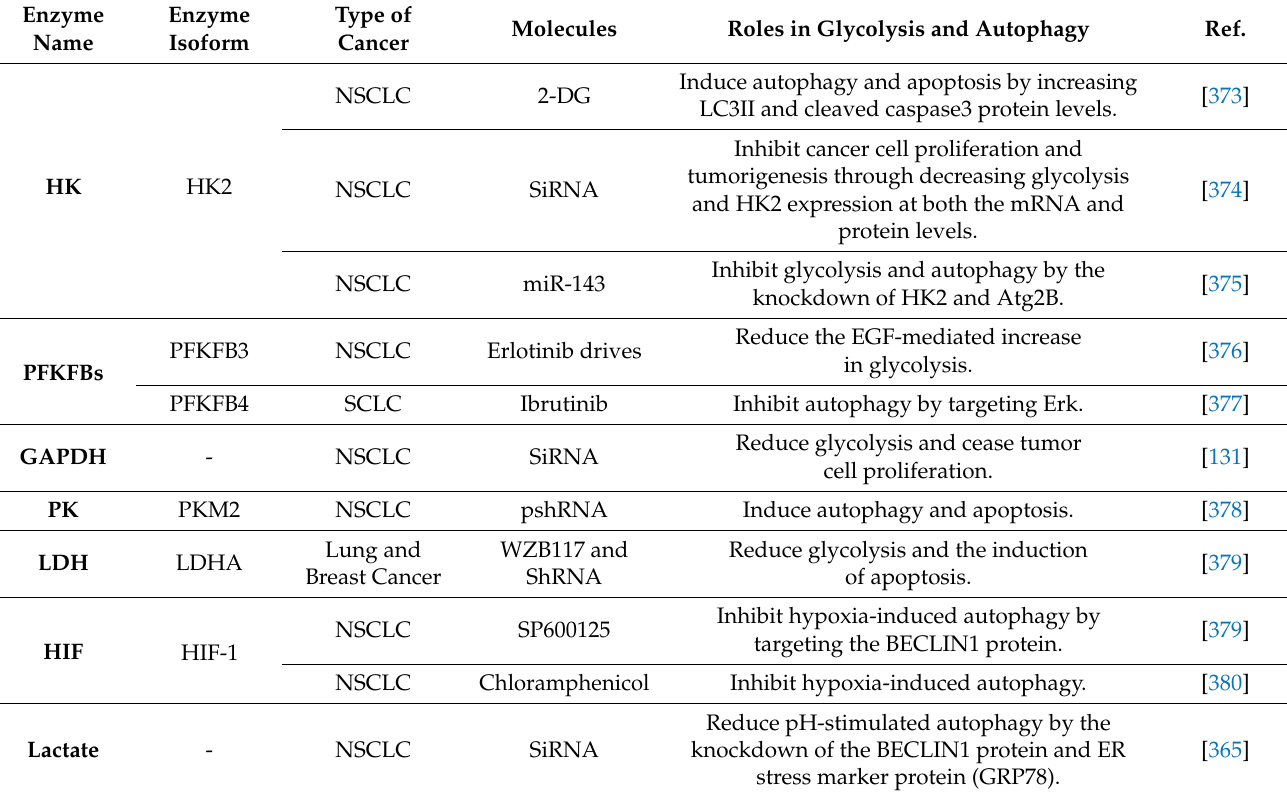
Table 4. The effect of enzymes involved in glycolysis on autophagy in lung